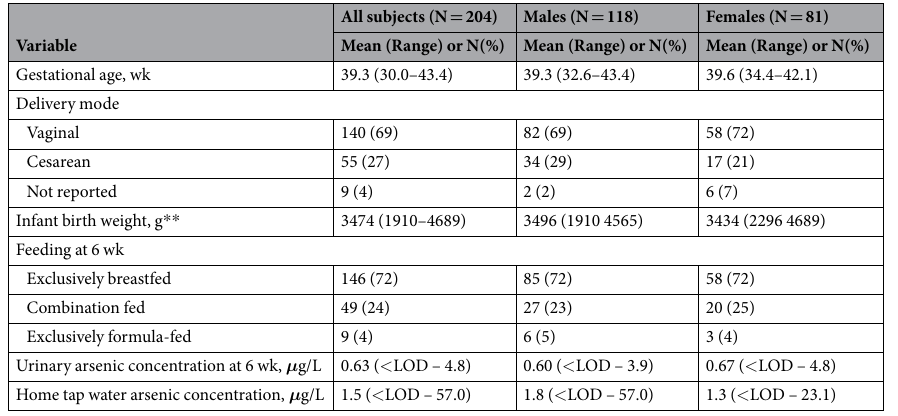
Table 1. Selected characteristics of participants overall and by sex * . LOD: limit of detection (0.05 μ g/L); * sex not reported for N = 5; ** birth weight missing for n = 7